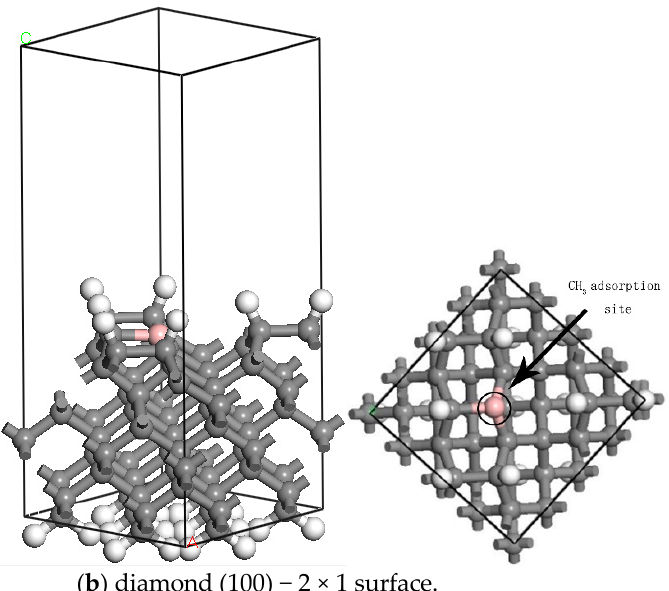
Figure 1. Representations of the supercells used in modeling the H-terminated substituted boron doped diamond surfaces.